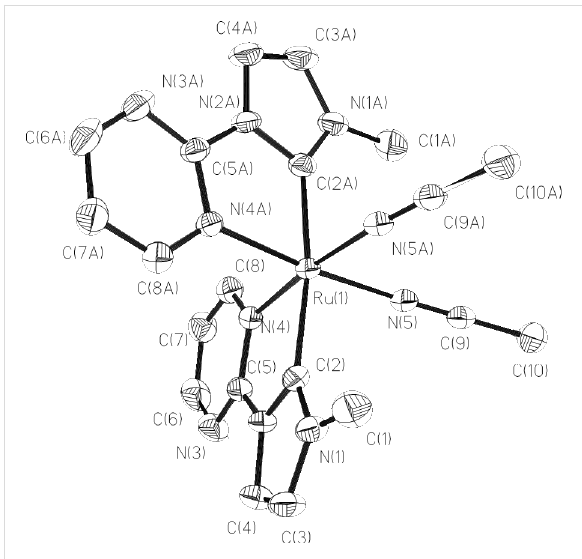
Figure 1: Structural view of 1 showing 30% thermal ellipsoids. All hydrogen atoms and PF 6 − were omitted for clarity. Selected bond lengths (Å) and angles (deg): Ru(1)–N(5) 2.033(4), Ru(1)–C(2) 2.066(5), Ru(1)–N(4) 2.081(4), N(5)#1–Ru(1)–N(5) 83.9(2), N(5)–Ru(1)–C(2) 87.87(16), C(2)#1–Ru(1)–C(2) 171.2(3), N(5)–Ru(1)–N(4) 91.12(16), C(2)#1–Ru(1)–N(4) 95.88(17), N(5)–Ru(1)–N(4)#1 174.20(14). Symmetry code: #1 − x, y, − z+1/2.